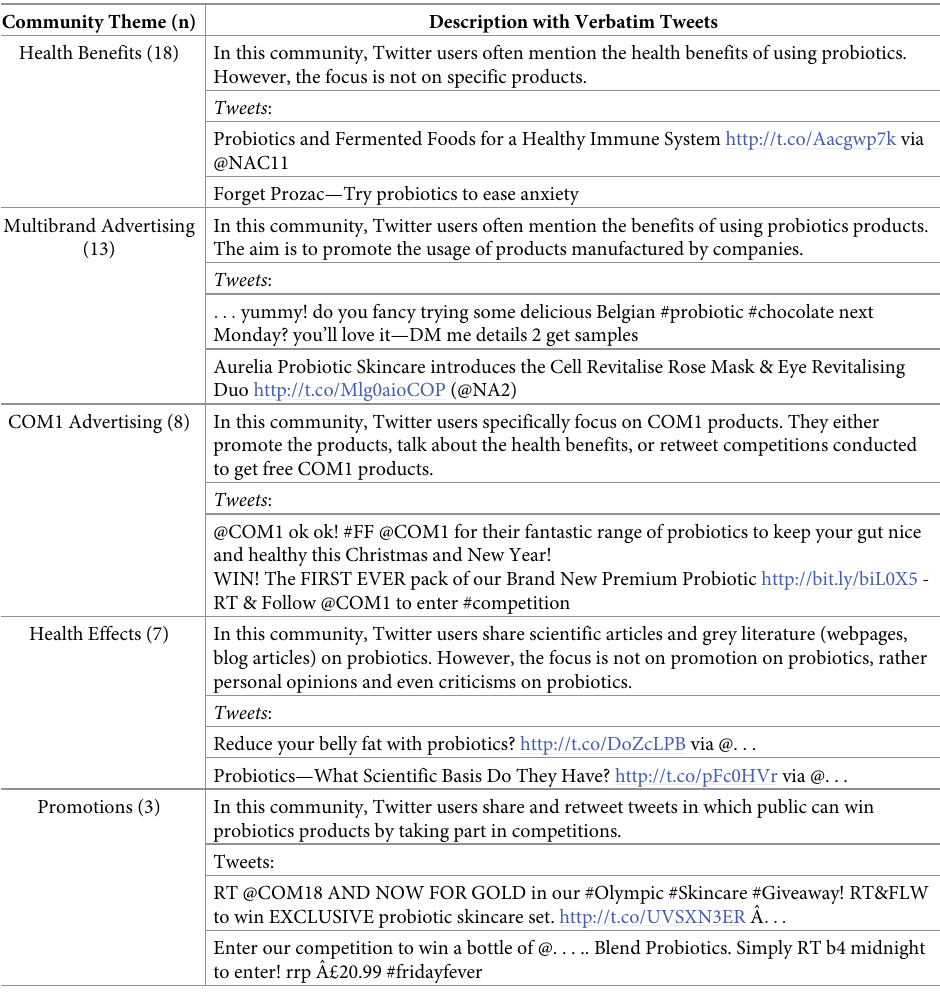
Table 3. Community themes with descriptions and